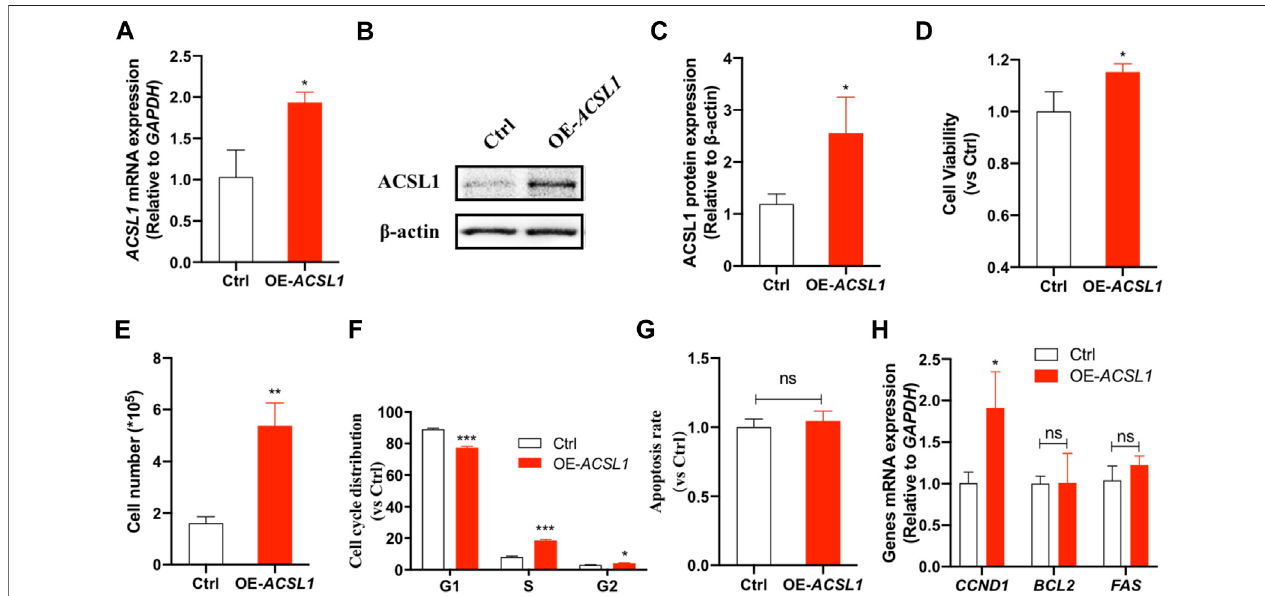
FIGURE 4 | ACSL1 overexpression promotes cell growth. (A) MAC-Tcells were transfected with pcDNA3.1- ACSL1 for 48 ° h, and fl uorescence quantitative qPCR was used to detect the changes of ACSL1 mRNA levels; (B,C) Western blot detects the protein expression of ACSL1; (D) CCK-8 assays were applied to check the cell viability after ACSL1 overexpression; (E) Living cell number in control (Ctrl) and ACSL1 overexpression (OE- ACSL1 ) groups; (F) Flow cytometry was applied to cell cycle progression; (G) Quanti fi cation of apoptosis by fl ow cytometry; (H) mRNA expression of cell cycle and cell apoptosis – related genes. GAPDH was used as inner control; * p < 0.05, ** p < 0.01, and *** p < 0.001, ns: nonsigni fi cant